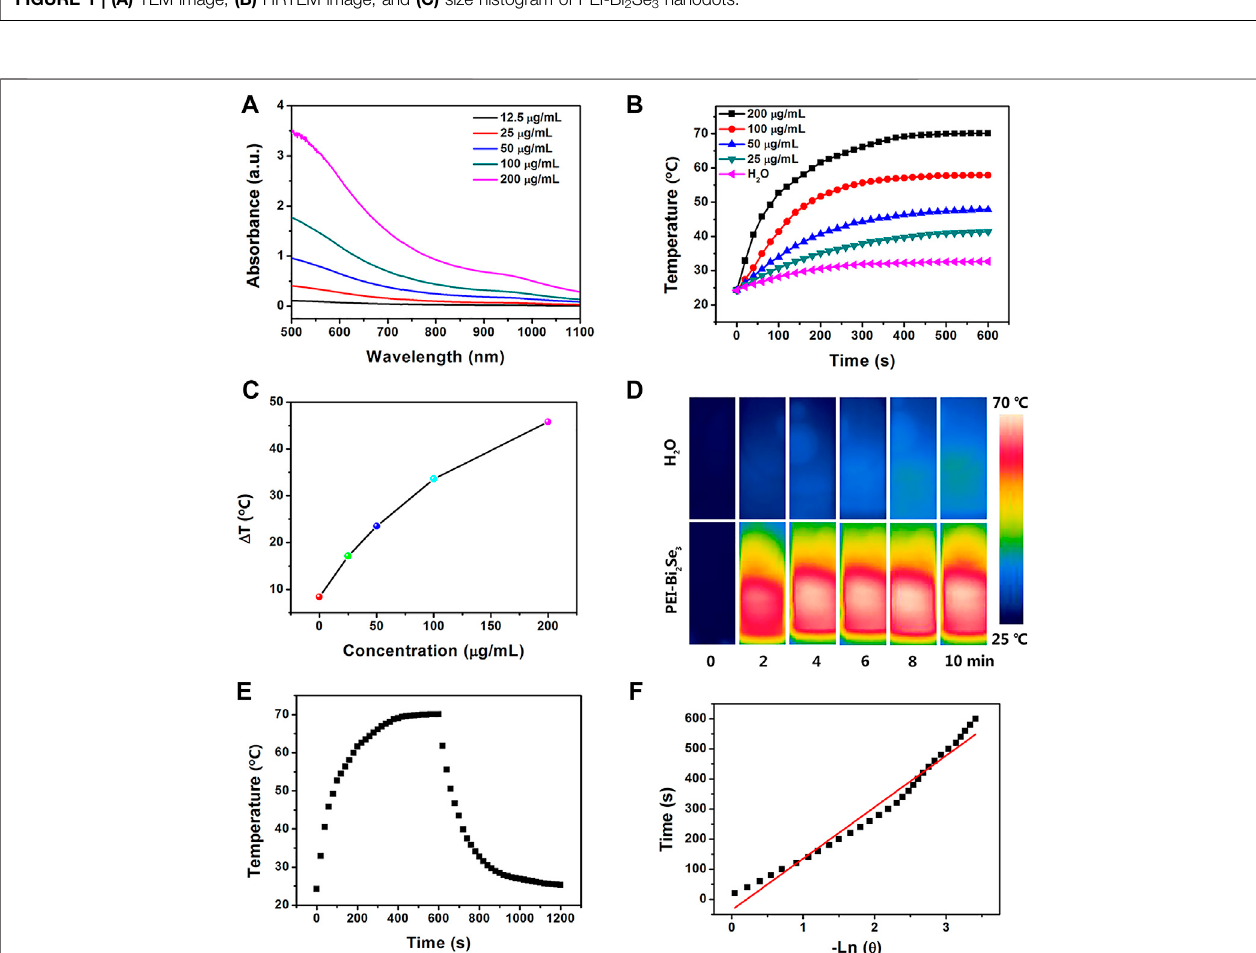
FIGURE2|(A) UV – Vis – NIRabsorptionspectraofPEI-Bi 2 Se 3 nanodotsinwaterwithdifferentconcentrationsofBi +3 . (B) Plotoftemperatureincreaseofpurewater and aqueous solutionsof PEI-Bi 2 Se 3 nanodotsofdifferentconcentrations upon exposure to aNIR laser at 808 nm (1.0 Wcm − 2 ) asa function ofirradiation duration. The temperaturewasmeasuredevery10 susingathermocouplemicroprobe. (C) Plotoftemperaturechange( Δ T )overaperiodof600 svs.theconcentrationofPEI-Bi 2 Se 3 nanodots. (D) IRthermalimagesofanaqueoussolutionofPEI-Bi 2 Se 3 nanodots(200 μ g ml − 1 )andpurewaterafterirradiationfor10 min(808 nm,1.0 W cm − 2 ). (E) Photothermal response of an aqueous solution of PEI-Bi 2 Se 3 nanodots (200 μ g ml − 1 ) after irradiation for 600 s with an NIR laser (808 nm, 1.0 W cm − 2 ). Subsequently, the laser was turned off. (F) Linear time data vs. − ln θ obtained after a cooling period of (E) .